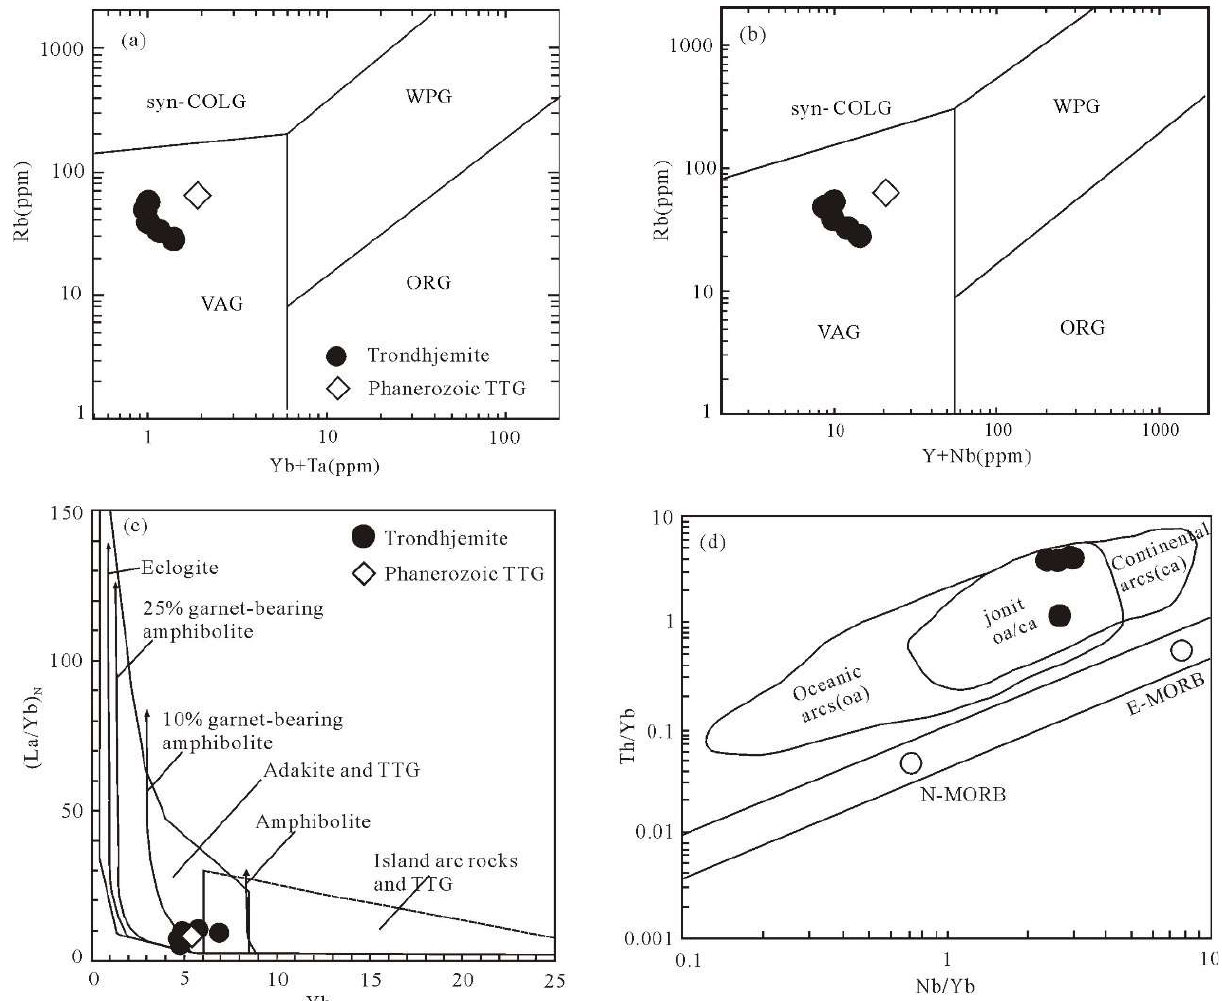
Figure 8. Rb vs. (Yb + Ta) diagram [58] ( a ), Rb vs. (Y + Nb) diagram [58] ( b ), (La/Yb) N vs. Yb N diagram [48,59] ( c ), and (Th/Yb) vs. (La/Yb) vs. Th diagram [60] ( d ) of the Gaolihan trondhjemite. Phanerozoic TTG data from Condie, 2005 [6].